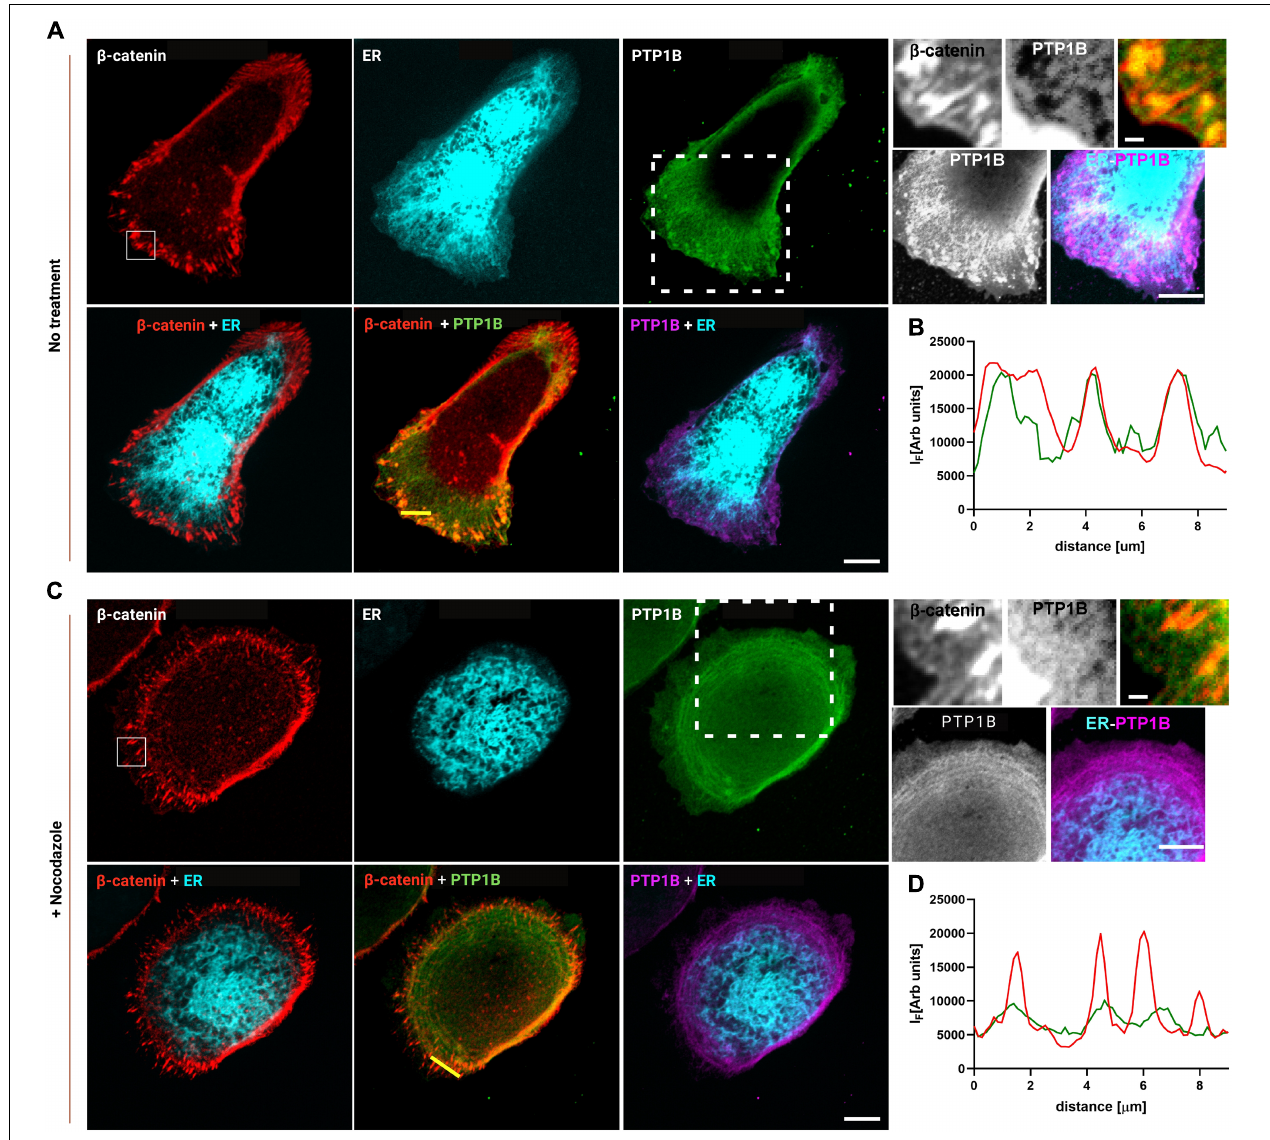
FIGURE 4 | PTP1B colocalizes with β -catenin at E-cadherin-mediated adhesions and is associated with the ER. MDCK cells transfected with calnexin-mEmerald seeded on E-cadherin biomimetic substrate in control (A) and after 1 h of nocodazole (10 µ m) treatment (C) . Top panel of (A,C) , representative images of MDCK cells transfected with calnexin-mEmerald (for ER identification, in cyan) and stained for β -catenin (red), and PTP1B (green). In the zoom image (white box in the β -catenin image), the colocalization of β -catenin (red) and PTP1B (green) is visible. In the enhanced contrast image (white dotted box in the PTP1B image), the colocalization of PTP1B (purple) and ER (cyan) is visible. Bottom panel of (A,C) , merged images for β -catenin/ER, β -catenin/PTP1B, and ER/PTP1B. In (B,D) , line profiles of the dotted lines in PTP1B/ β -catenin merged images, for β -catenin and PTP1B, respectively. Images were acquired by spinning disk confocal microscope with a × 60 objective, 1.49NA Plan-Apo (Nikon). Scale bar, 10 µ